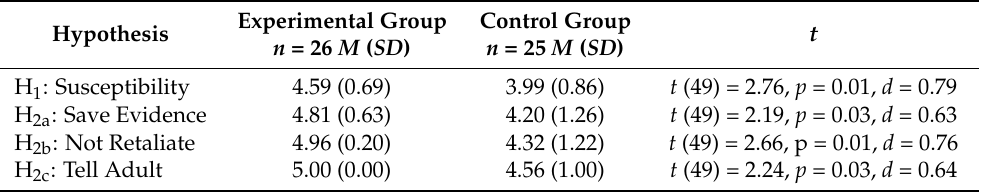
Table 1. Means (and standard deviations) for all